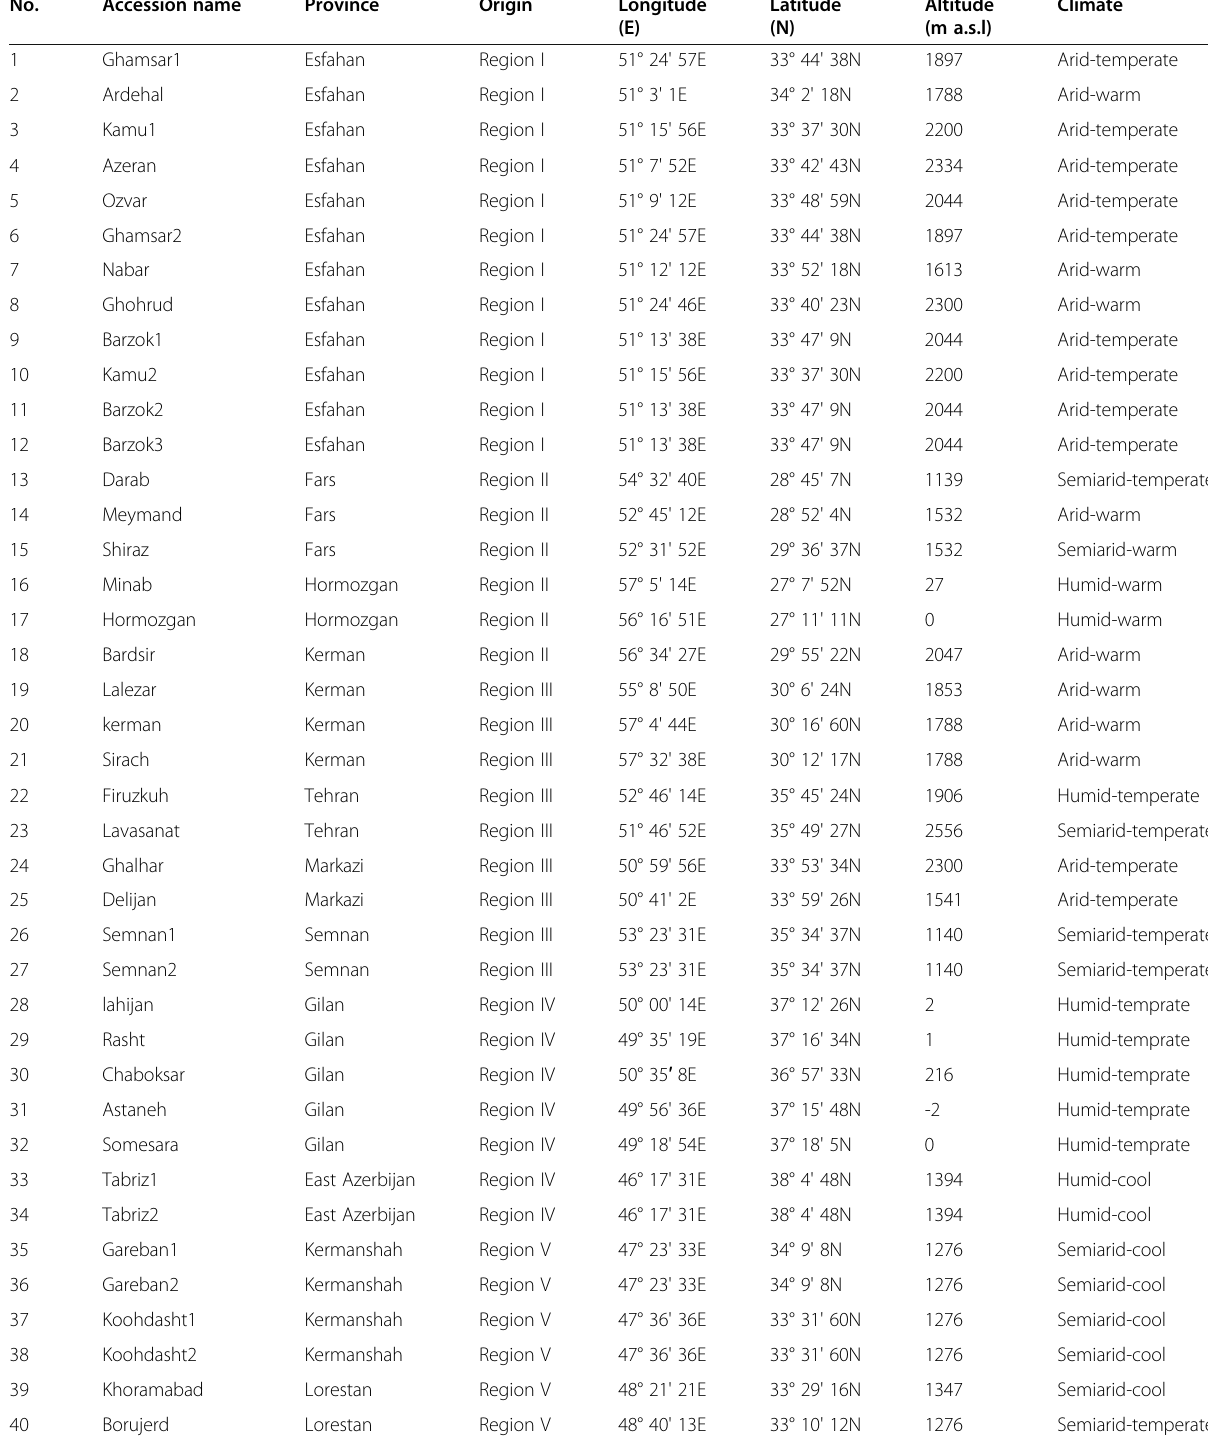
Table 1 Details of rose accessions used in the study